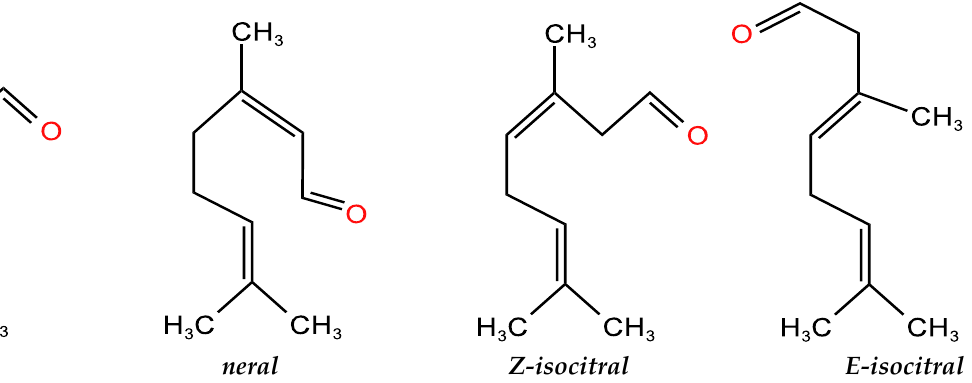
Note: Table presents only the compounds for which the peak area exceeds 0.1% in chromatograms